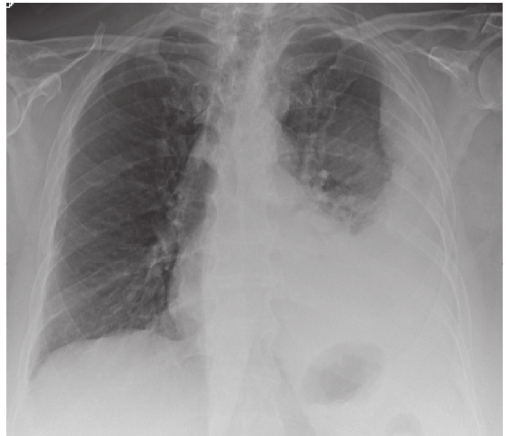
Figure 1: Portable upright chest radiograph, demonstrating loculated left-sided effusion with associated infiltrate and lobar